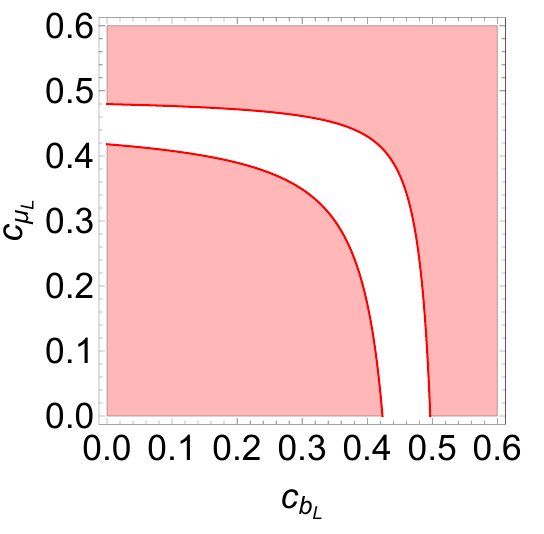
Figure 5 . Region in the ( c b We display the result for c e